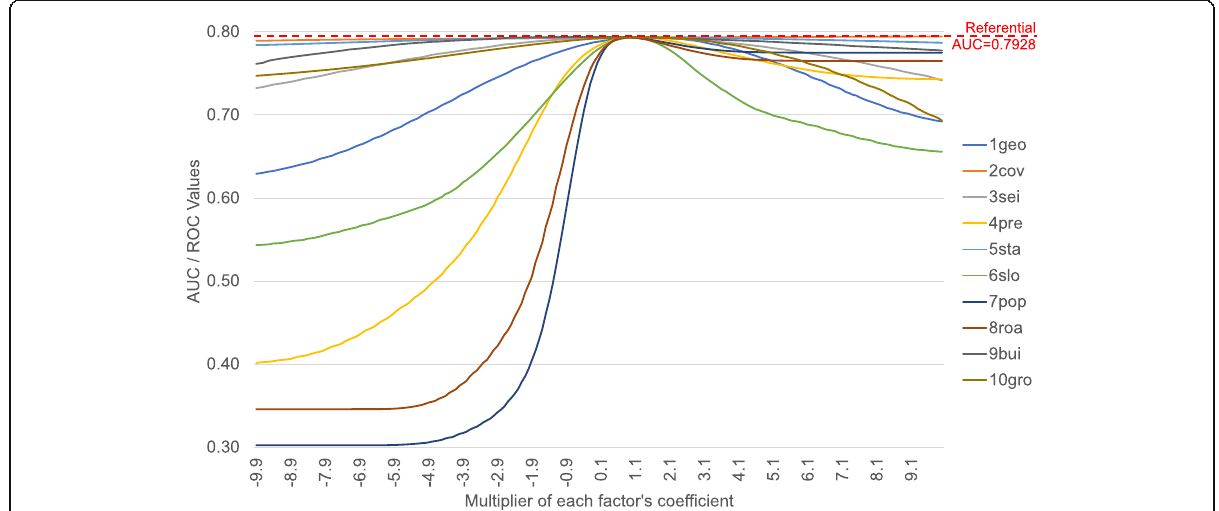
Fig. 4 Univariate sensitivity analysis for LOGIT model (weights-encoding) showing AUC values as a metric of the impact of coefficient variations on the model performance. Legend: Lines represent factors: 1geo = lithology (electric blue), 2cov = land use/vegetation coverage (orange), 3sei = seismicity (light gray), 4pre = precipitations (yellow), 5sta = soil stability (light blue), 6slo = slope (green), 7pop = population (dark blue), 8roa = road density (brown), 9bui = floor area (dark gray) and, 10gro = building footprint area (ochre). X-axis shows the multipliers of each factor ’ s coefficient and Y-axis shows the AUC/ROC values. The referential AUC value is shown in the dashed red line